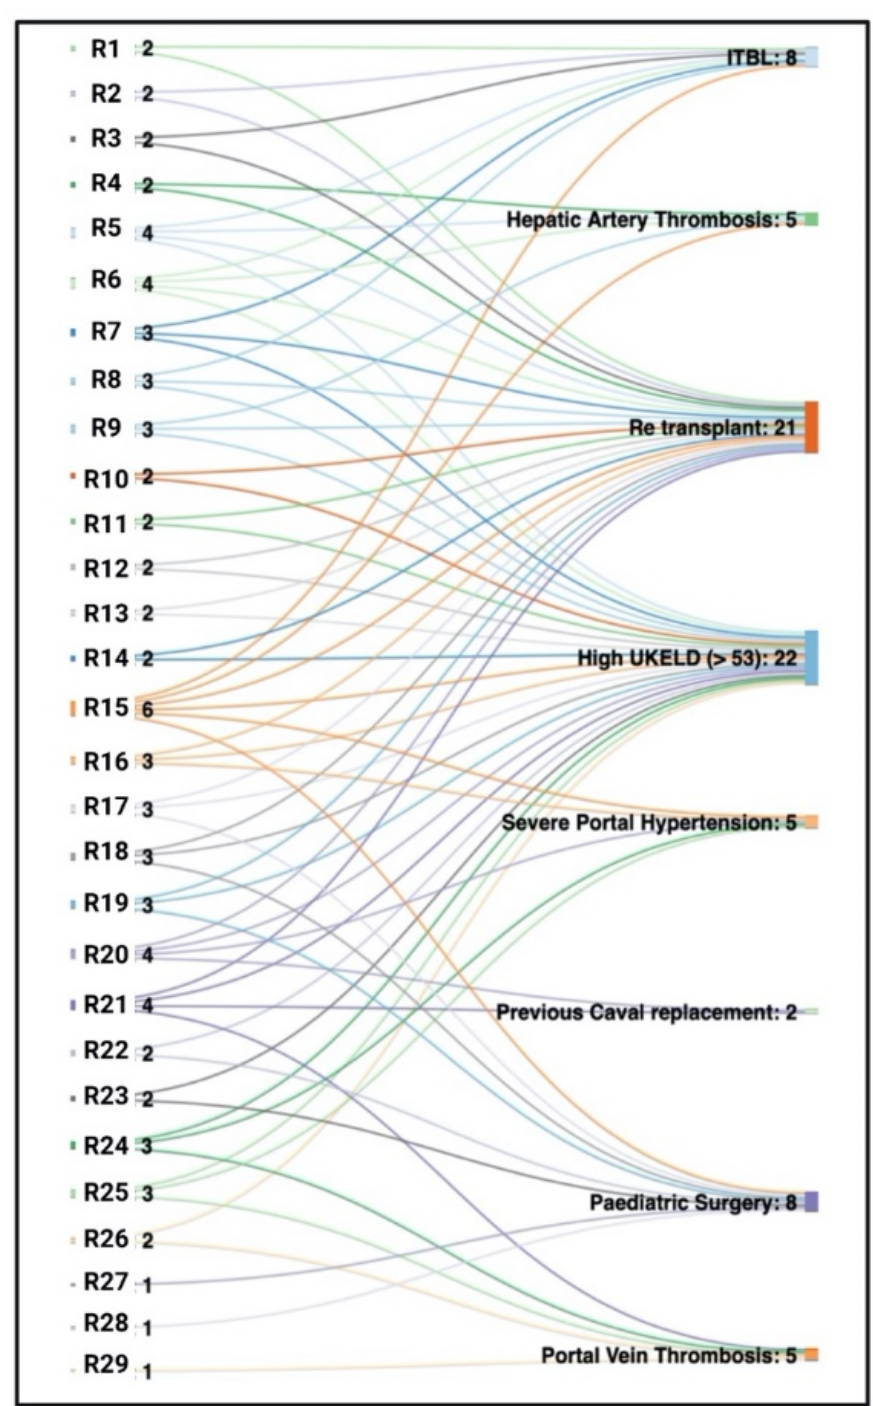
Figure 3. Sankey diagram explaining the accumulated risk factors of high-risk recipients. Early Birmingham experience in the initial cohort of 29 consecutive high-risk patients transplanted with NMP-preserved grafts. Several high-risk features frequently coexist in one recipient. This diagram demonstrates that the majority of patients have two or more of these characteristics, making them technically challenging recipients. R, recipient number followed by cumulative risk factors (for example, R18 3 denotes recipient 18 had three high-risk factors) ; ITBL, ischaemic-type biliary lesions; UKELD, United Kingdom model for end-stage liver